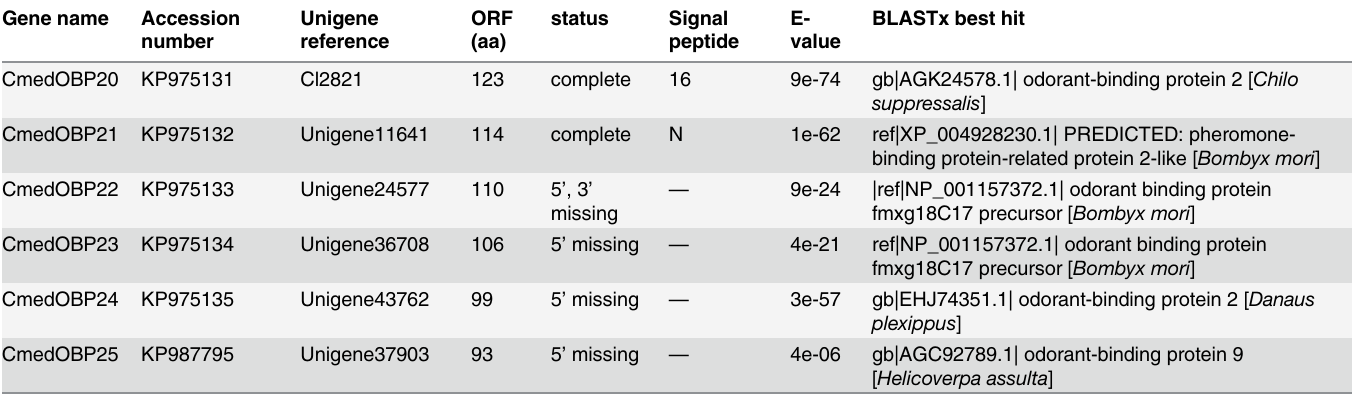
Table 6. Unigenes of candidates for odorant binding proteins.